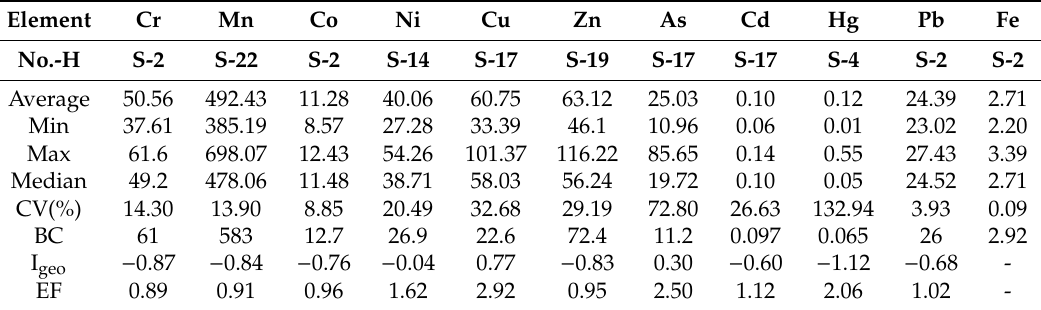
Table 1. Heavy metal (mg / kg) and Fe (%) concentrations of soil in the study area. Element